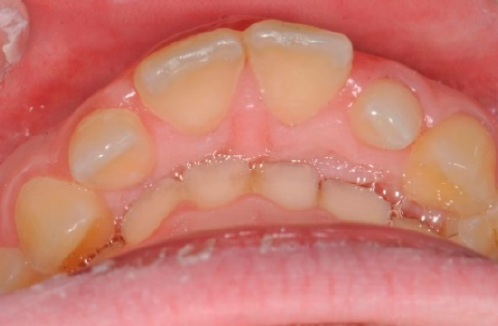
Figure 6. Overbite.